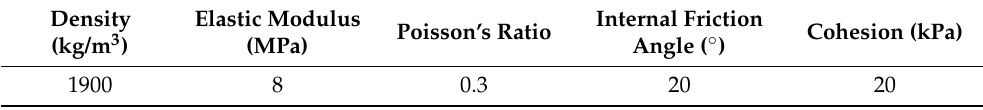
Table 1. Material parameters of the soil.